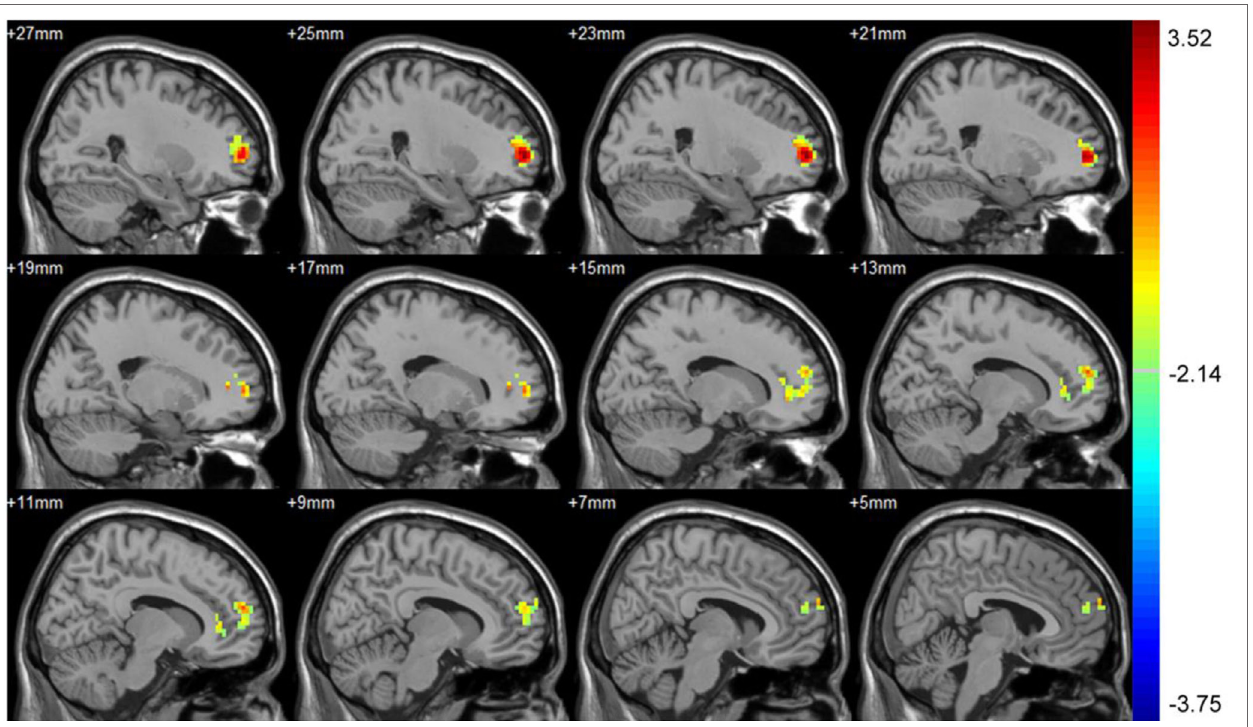
FigUre 3 | Significant connectivity difference to the posterior cingulate cortex (PCC) between baseline and 3 months after intervention. After treatment, the asymptomatic carotid artery stenosis patients showed the increased connectivity to the PCC mainly in the right supra frontal gyrus. The result was corrected using the AlphaSim program, by setting at P < 0.01 and number of voxels > 142, which corresponded to a corrected P <